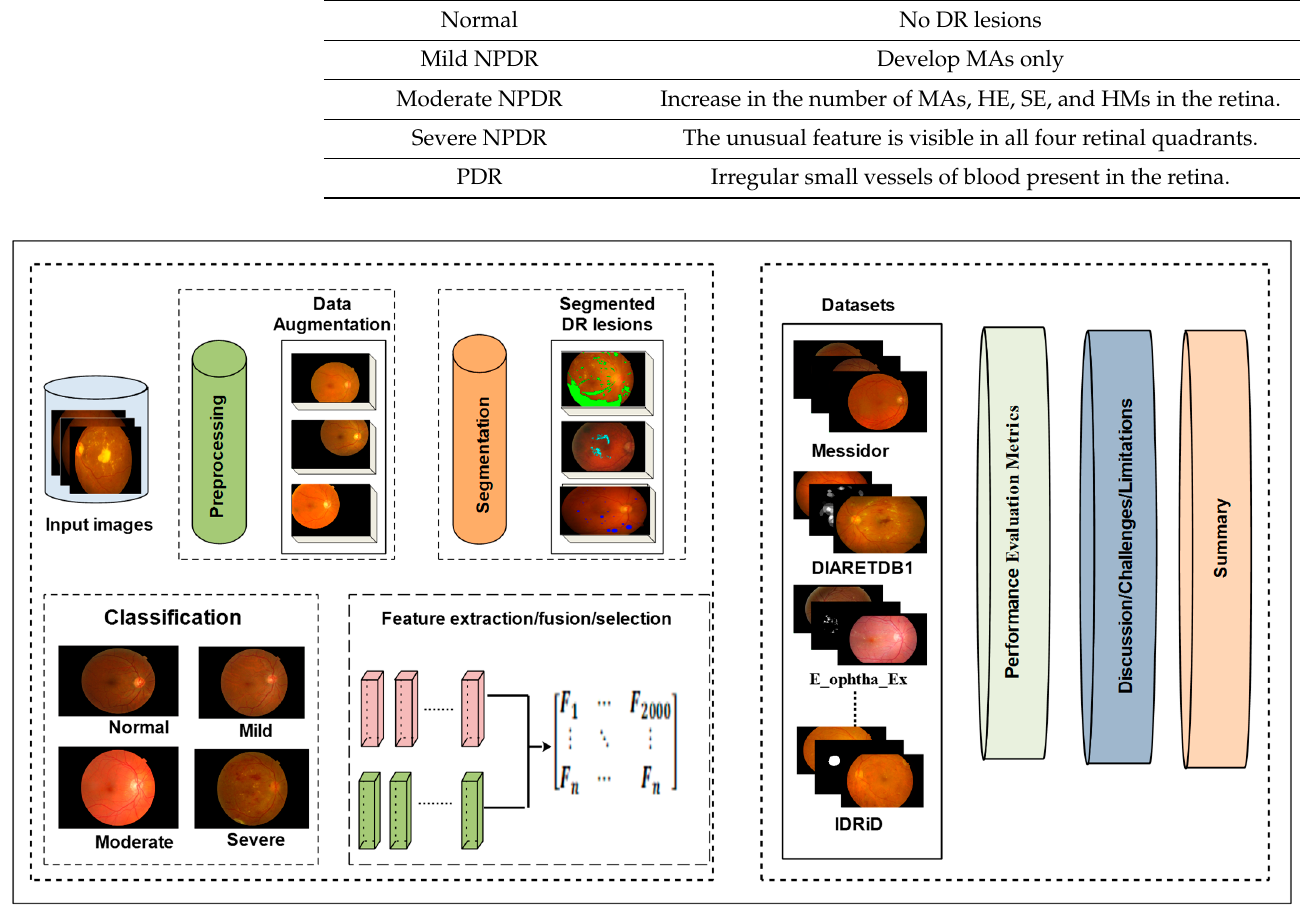
Figure 2. Framework of survey . Table 2. Comparison between this study and other surveys .